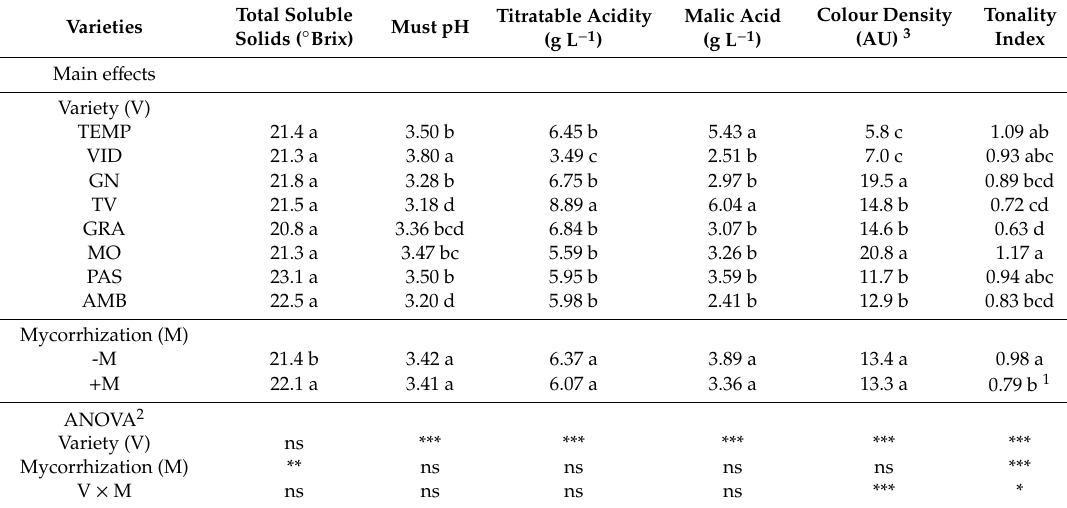
Table 4. Main e ff ects and their interaction on must characteristics from fruit-bearing cuttings of ancient grapevine varieties inoculated with arbuscular mycorrhizal fungi ( + M) or non-inoculated (-M). The variety labels can be found in Table